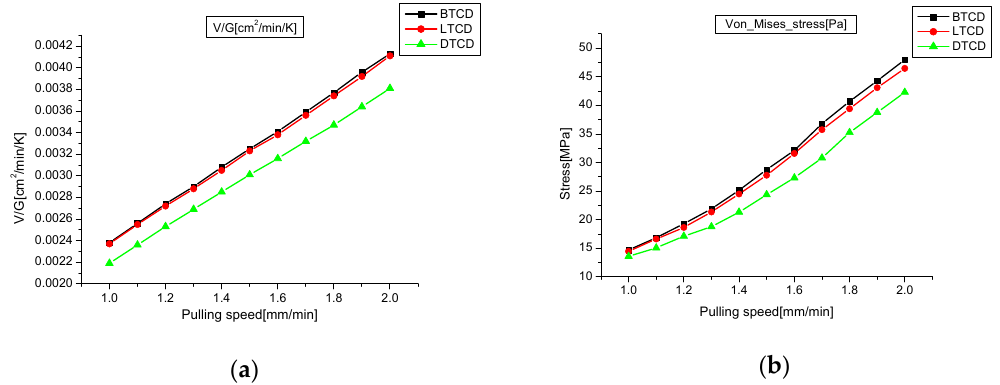
Figure 9. Results at a high pulling speed for each CP3000 design ( a ) V/G and ( b ) von Mises stress. Table 4. CG-Sim analysis results at various pulling speeds between 1.0 and 2.0 mm/min at CP3000. Pulling Speed